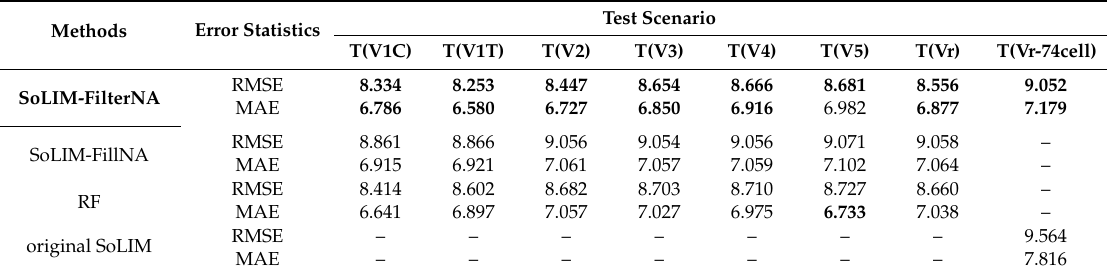
Table 3. RMSE and MAE of the errors on the top-layer SOM (g / kg) predicted by di ff erent methods under cell-level test